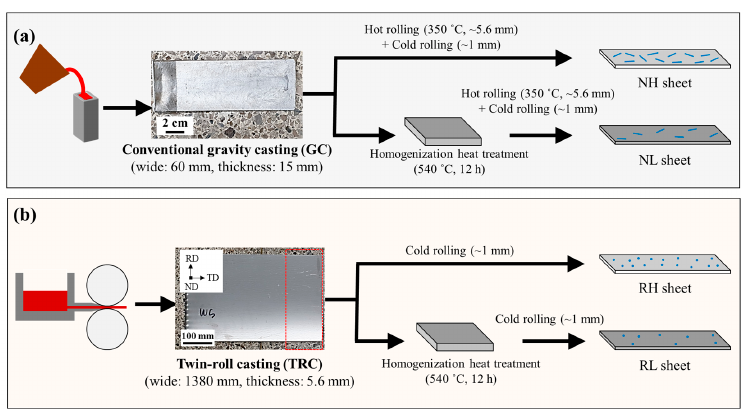
Figure 1. Schematic of the manufacturing method of NH, NL, RH, and RL sheets. The prepared GC and TRC alloys were each made into sheets using two different processes: ( a ) rolling without homogenization heat treatment and ( b ) rolling after homogenization heat treatment at 540 °C for 12 h.